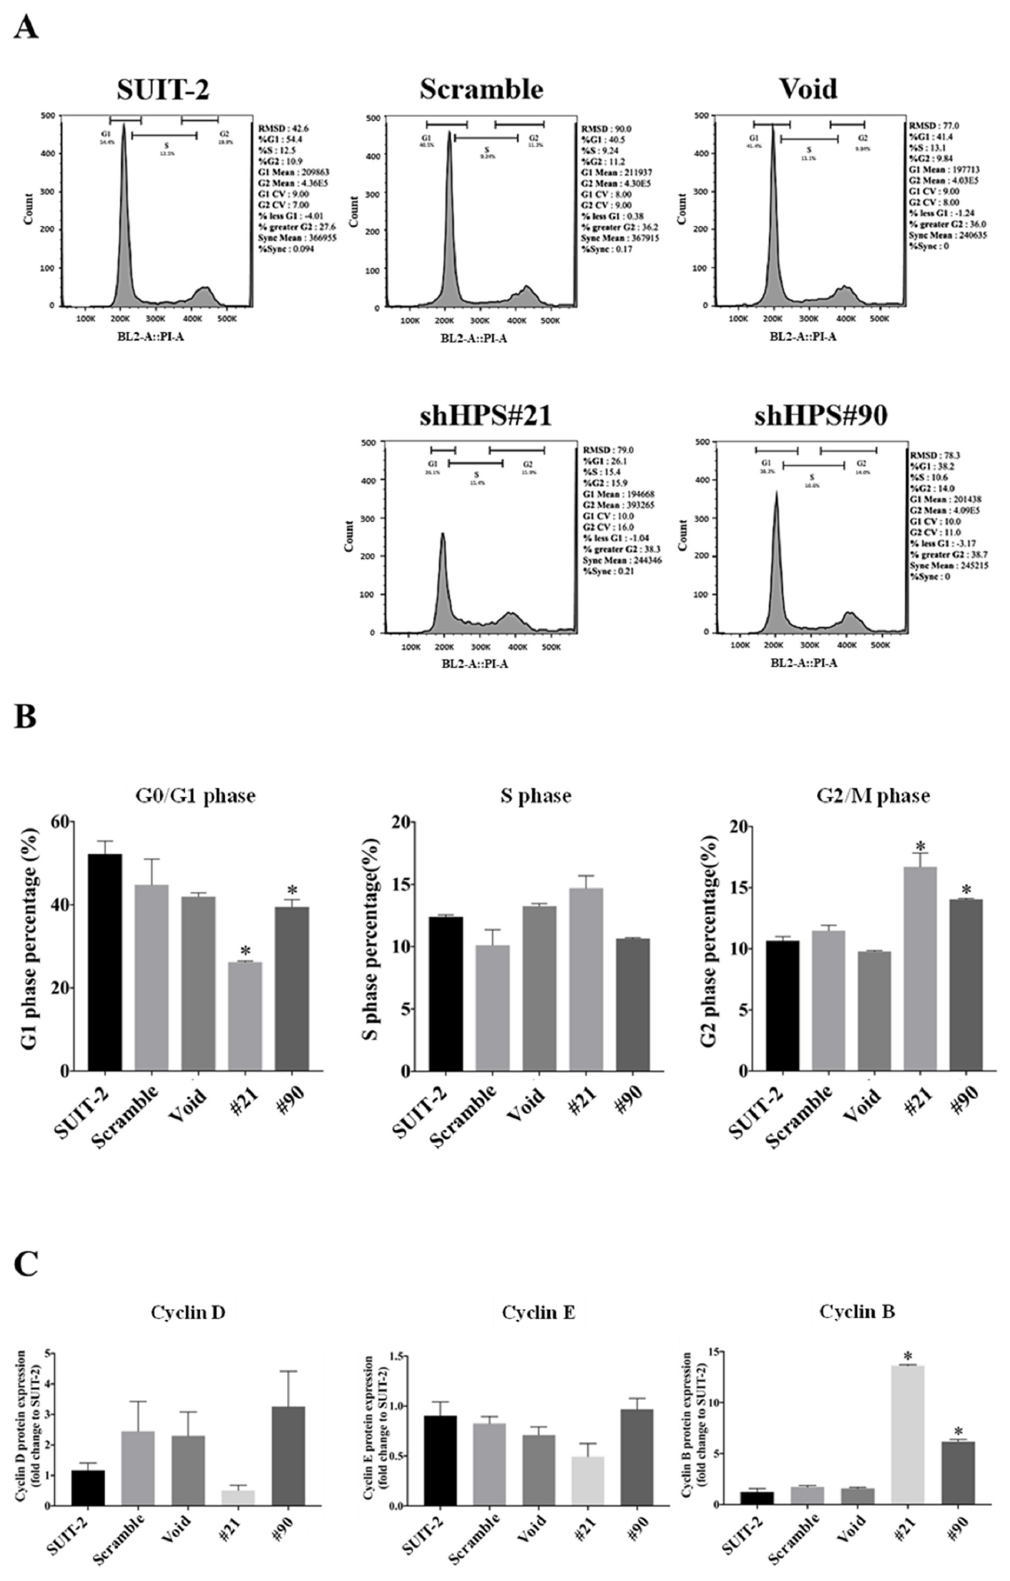
Figure 3. Knockdown of hepassocin (HPS) induces cell cycle arrest in SUIT-2 cells. ( A ) SUIT-2 cells were infected with a lentivirus carrying control vectors of Scramble and Void and the short hairpin (sh) HPS vectors #21 and #90, the